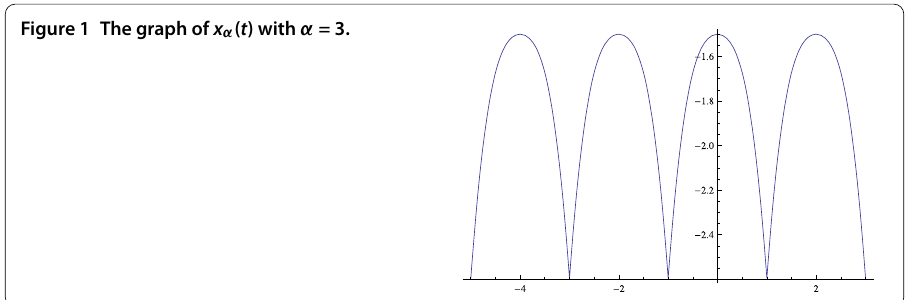
Figure 1 The graph of x α ( t ) with α =